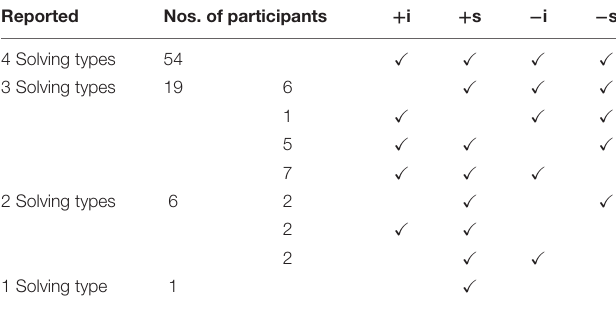
TABLE 3 | Breakdown of participants’ reported solving as positive insight ( + i), positive search ( + s), negative insight ( − i), and negative search ( − s).